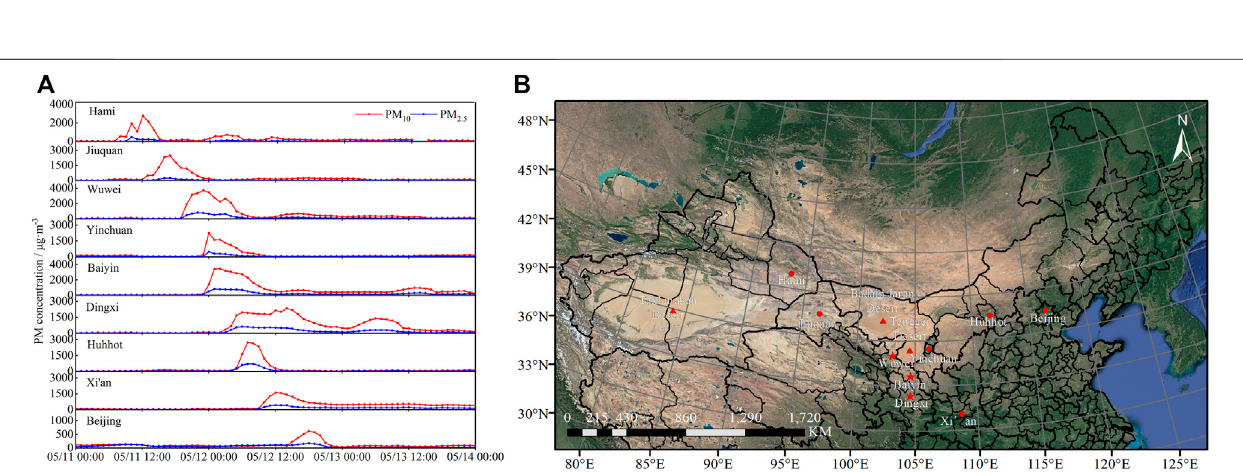
FIGURE3| HourlyconcentrationofPM 10 andPM 2.5 ofninecitiesfrom00:00on11Mayto00:00on14May (A) ;locationsofthestudiedcitiesandtheirsurrounding geomorphic characteristics, C represents cities, ▲ represents deserts, and + represent lidar stations (B) .